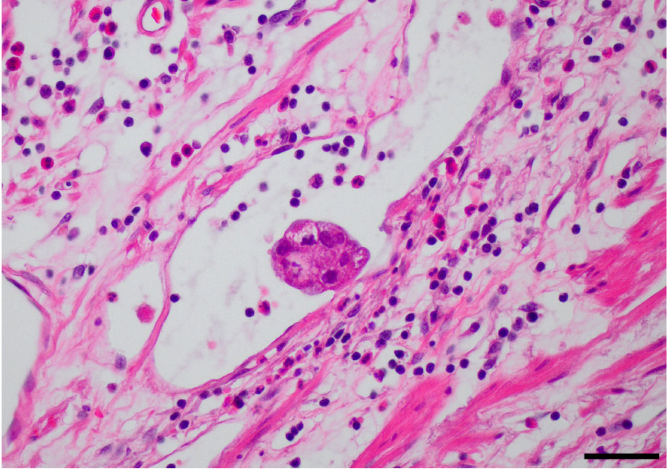
Figure 3. Lymphovascular invasion on Hematoxylin and Eosin (H-E) staining (magnification 400 × , Scale bar = 50 µ m). Lymphovascular invasion can be identified by the presence of cancer embolus in the lumen cavity formed by a lumen of the endothelial cell monolayer. However, H-E staining could not accurately differentiate between the lymphatic and capillary